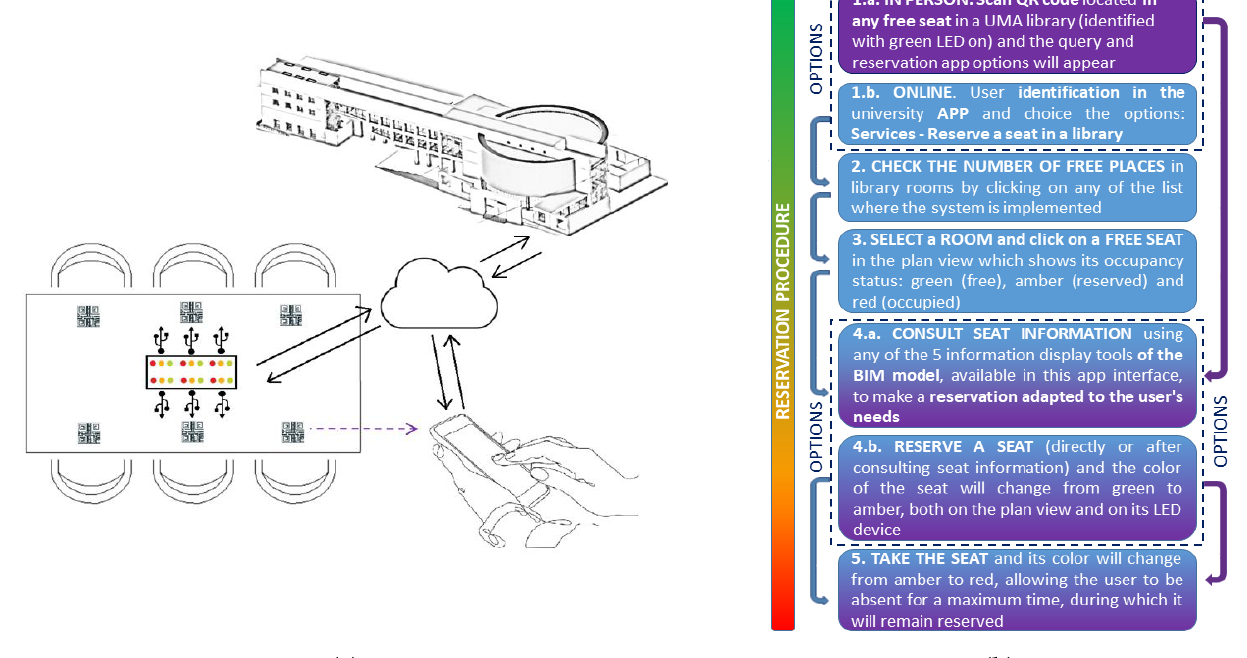
Figure 9. Diagram of the reservation procedure and system communication flows. Clockwise, we have ( a ) the cloud-hosted BIM model, ( b ) the user’s smartphone with the UMA app. As an alternative to booking online, the option of booking in person is also possible. After comparing the data and choosing the desired seat or without having previously used the query option, users can click on the “Reserve seat” option, and it will appear as reserved (amber) both in the application’s occupancy map and on the LED of the device.